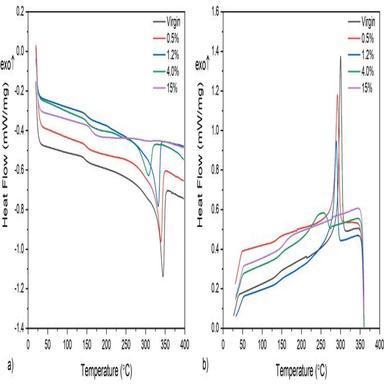
DSC thermograms of a) the second heating cycle and b) the cooling cycle for the virgin PEEK and the PEEK samples that have lost 0.5%, 1.2%, 4% and 15% of their initial mass (heating rate: 100 ◦C/min).